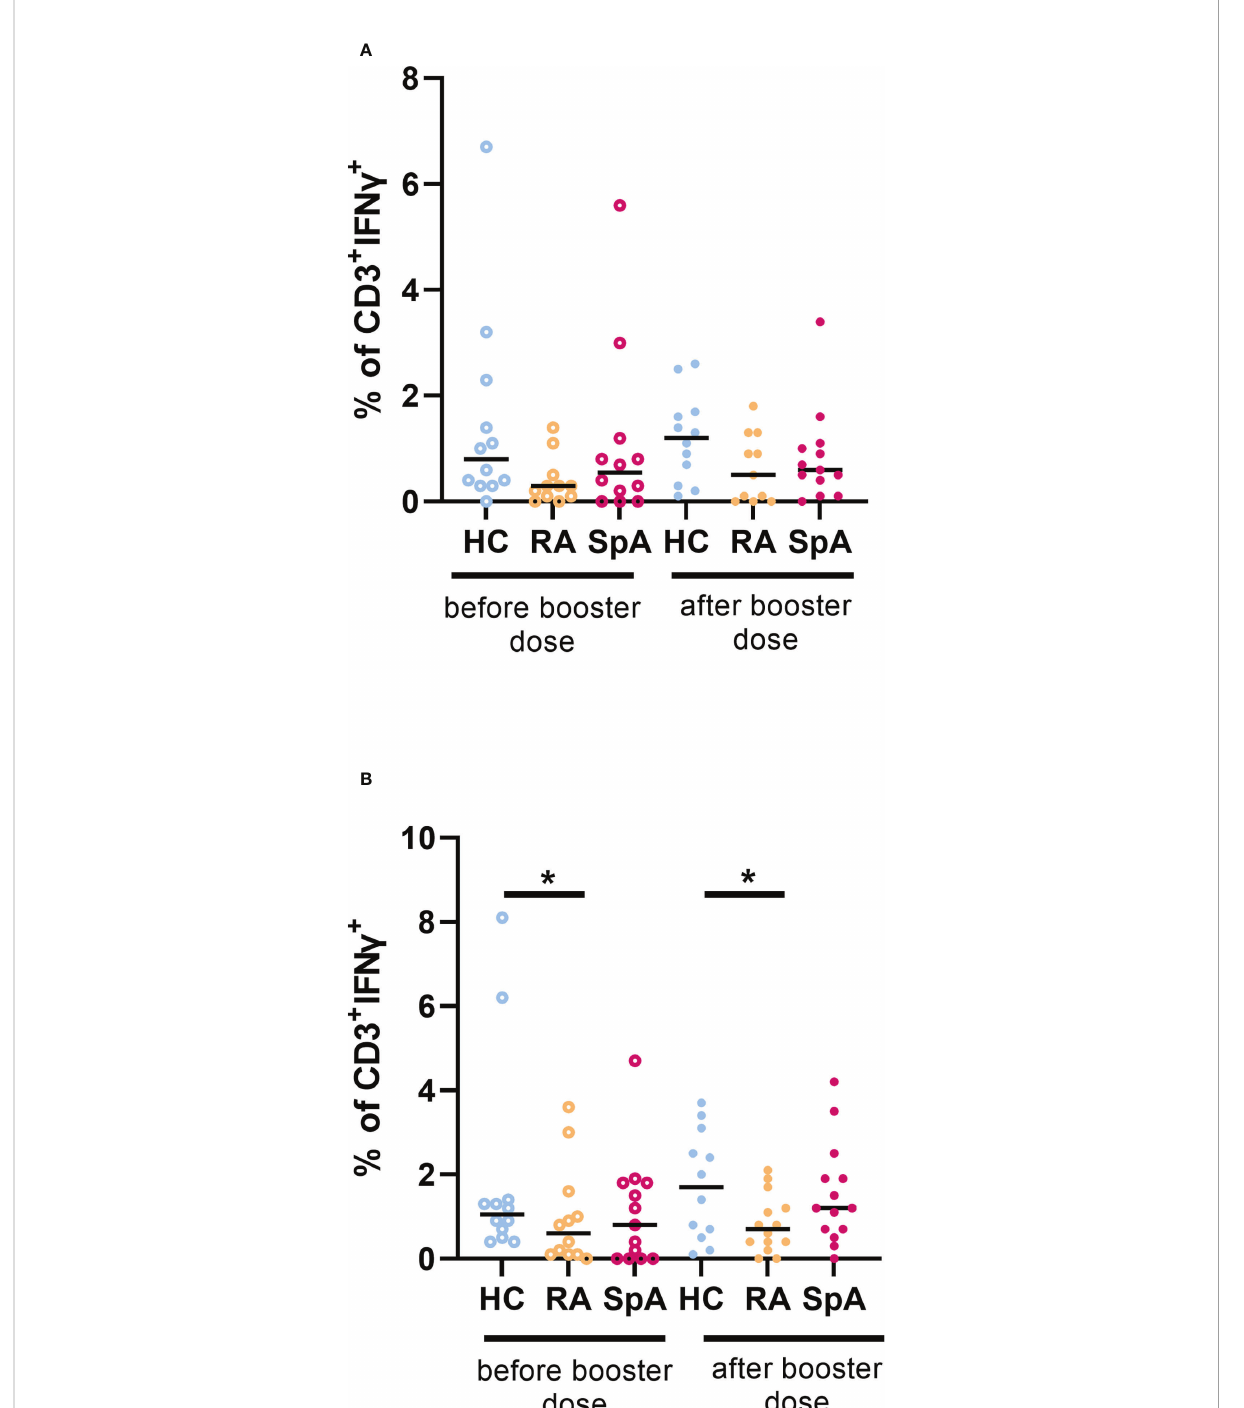
FIGURE 3 (A) Percentage of CD3+ INF- g + cells after wild-type viral protein stimulation in patients with rheumatoid arthritis (RA; n=10) and spondyloarthritis (SpA; n=14) compared to healthy controls (HC; n=12) before and after a booster dose of COVID-19 vaccine. (B) Percentage of CD3+ INF- g + cells after delta viral protein stimulation in patients with RA (n=11) and SpA (n=15) compared to HC (n=11) before and after booster dose of COVID-19 vaccine. In the group comparison, the Kruskal – Wallis test with post hoc analysis with the Dunn ’ s test was performed. Dots represent individual values and the line represents the median. A p values were expressed as follows: 0.05>p>0.01